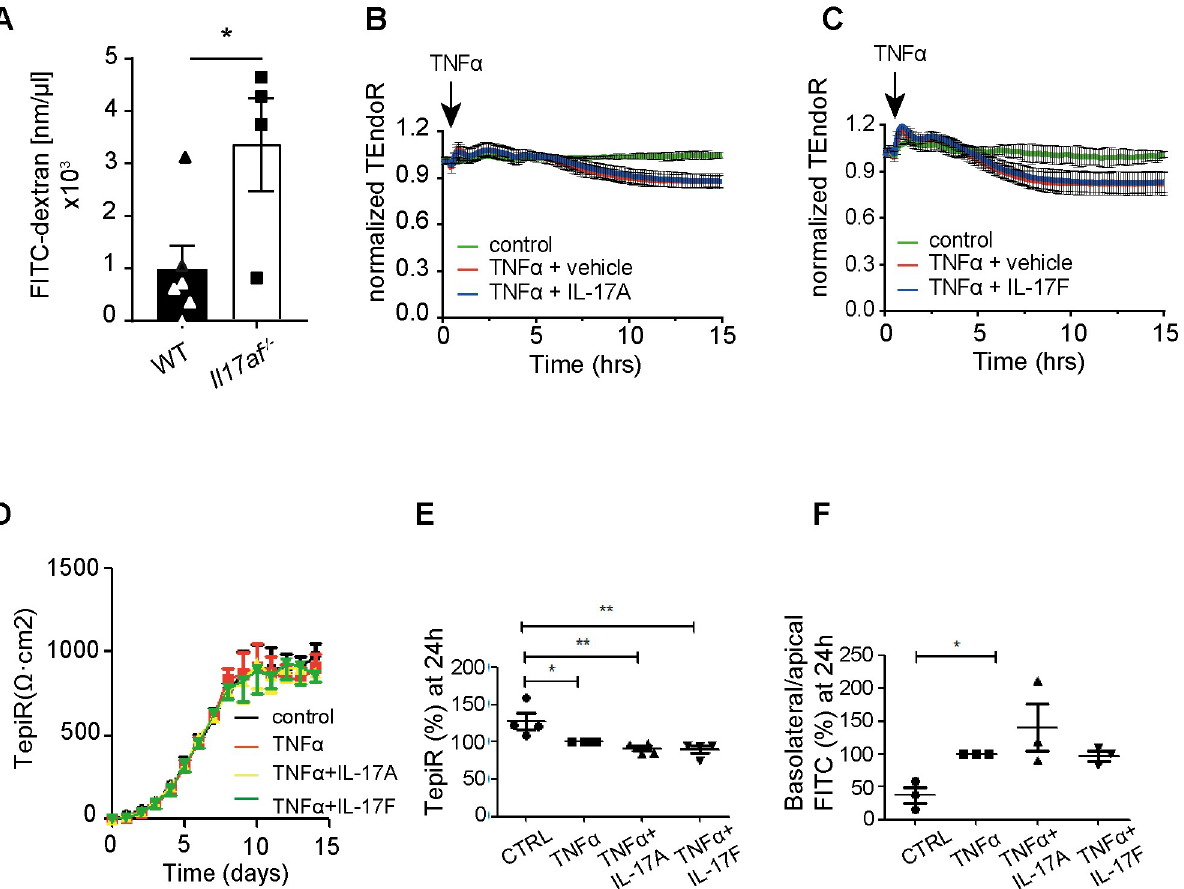
Fig 4. Recipients of Il17af -/- CD4 + cells show gut-leakiness. BALB/c mice were lethally irradiated and transplanted with 5x10 6 TCD BM and 0.5x10 6 CD4 + cells from BL6 WT or Il17af -/- donors. A) Concentration of translocated FITC-dextran in the sera of WT and Il17af -/- CD4 + T cell recipients at day 21 after BMT. (n = 6, Il17af -/- n = 4) B) Increase in transendothelial electrical resistance (TEndoR) normalized to vehicle. C) Increase in transepithelial electrical resistance (TepiR, measured daily with an EVOM2 voltohmmeter, over the days in culture after confluency. All four groups had a similar increase in TEpiR prior to the cytokine treatment. D) at day 14 post confluency, the cells were incubated with 10ng/ml interferon- γ ± IL17A or IL17F, followed by 10g/ml TNF- α 10ng/ml ± IL-17 (IL-17A or IL-17F 10ng/ml) 24 h later, and TEpiR was assessed at the indicated times. E) After 24h, the filters were transferred to an Ussing-chamber system, and both TEpiR, and F) FITC permeability was assessed. The values in C and D are given in % of the value treated with IFN- γ and TNF- α only. All data are pooled from two or three independent experiments. Error bars represent SEM. For statistical analysis Log-rank test was used. � p �